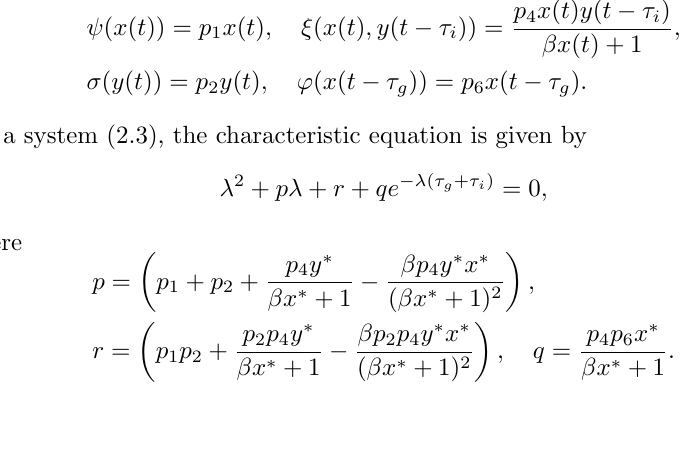
Table 1. De Gaetano and Arino’s parameter values for subjects 6 and 7